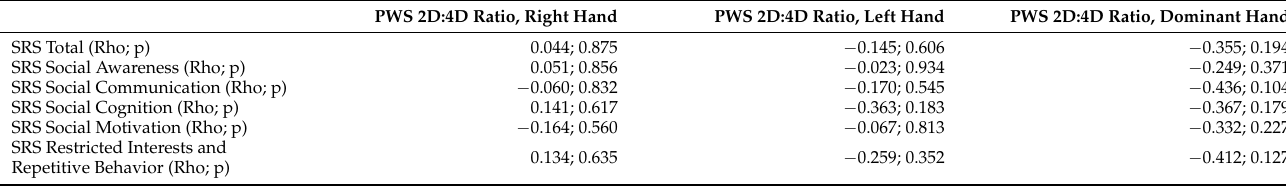
Table 3. Bivariate correlations in female PWS participants (n=15) for 2D:4D ratios. PWS 2D:4D Ratio, Right Hand